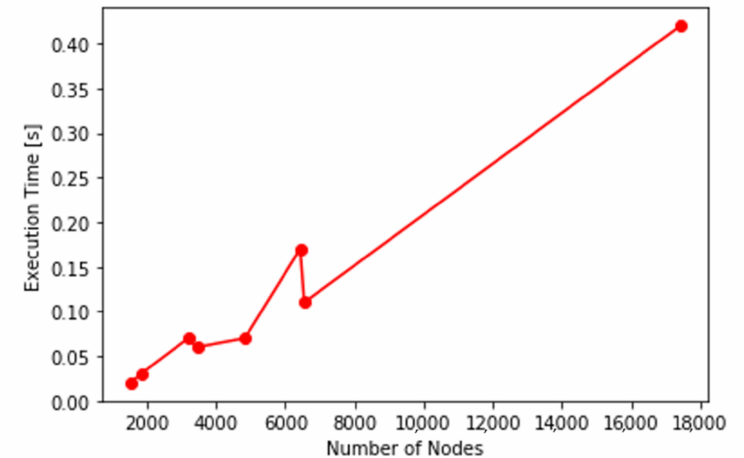
Figure 15. Execution time of the netlist write-out function against the number of